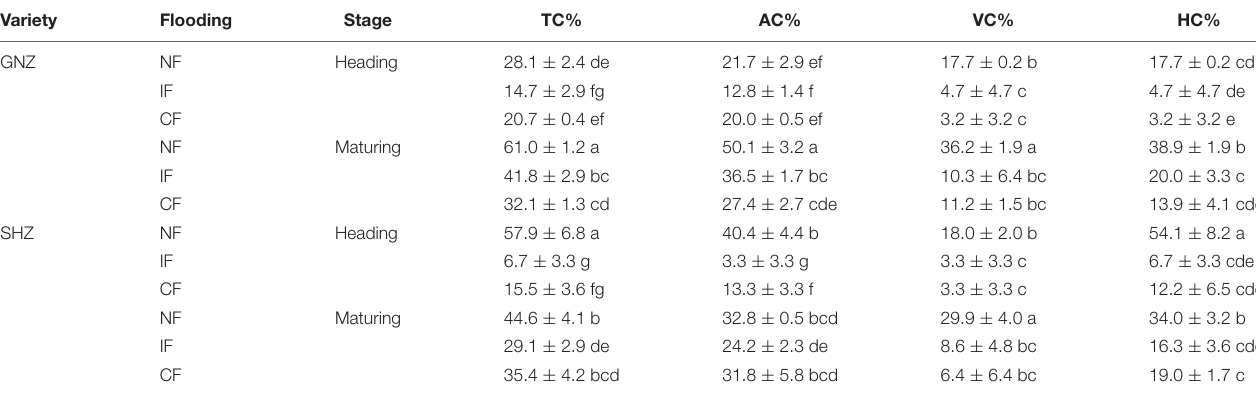
TABLE 1 | Arbuscular mycorrhizal fungi (AMF) colonization intensity in the rice roots collected at the heading and mature stages from none, intermittent, and continuous flooding (NF, IF, and CF, respectively) conditions. Variety